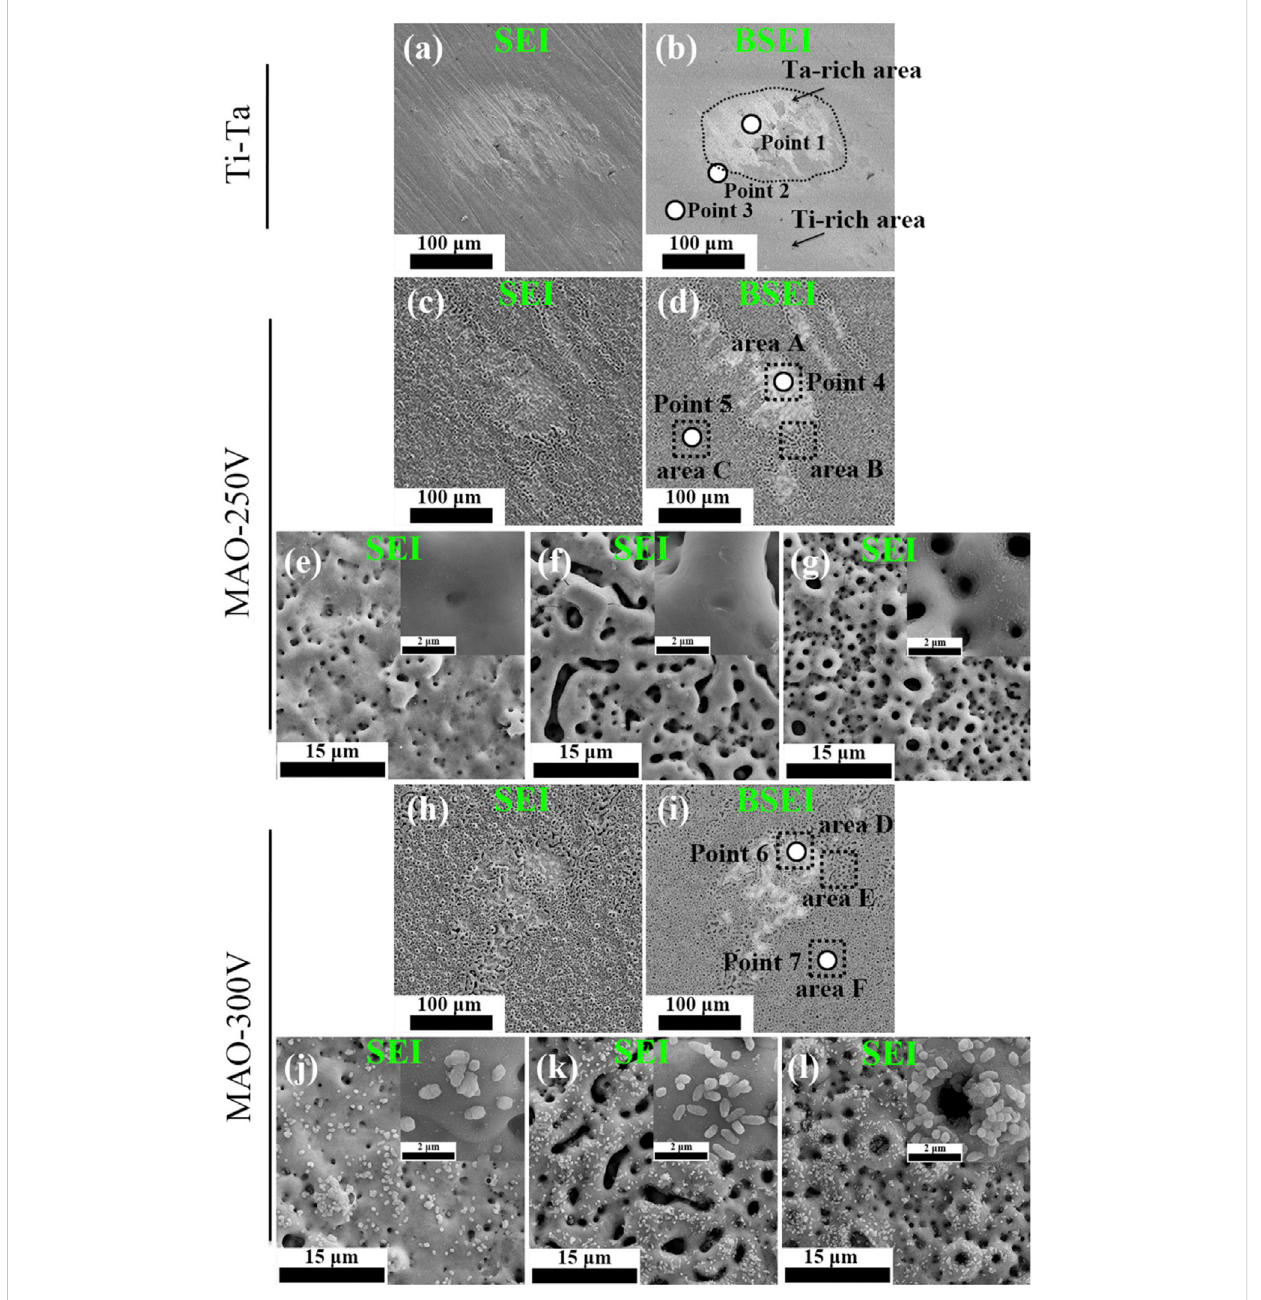
Secondary electron and backscattered electron SEM images showing the morphological features of various surfaces. Figures (E – G) and (J – L) correspond to areas (A – F) indicated by the black dashed lines in Figures (D) and (I) , respectively (Huang et al., 2018). Copyright ©2018 Published by Elsevier